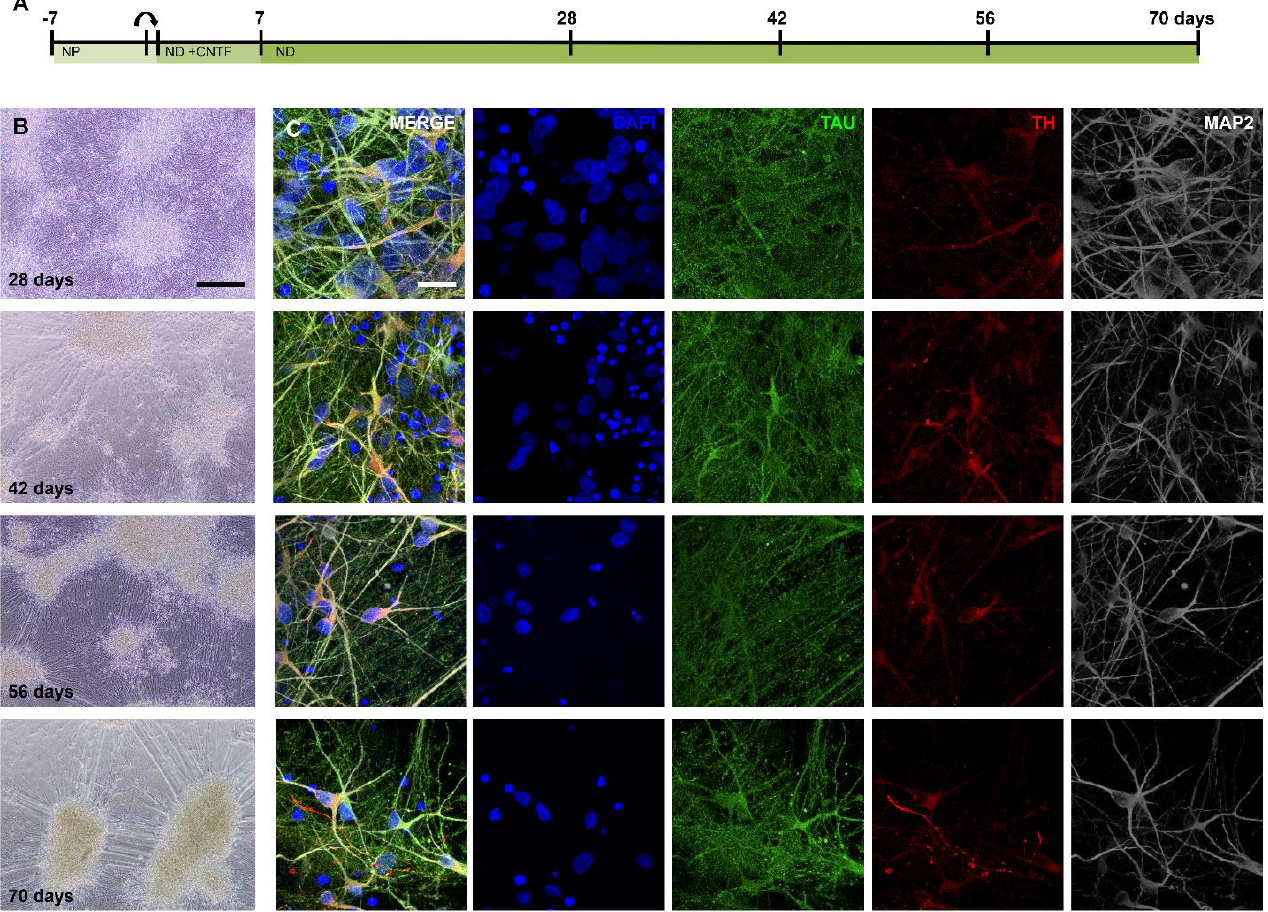
Figure 2. Differentiation of NPC to neuron-astrocyte culture including dopaminergic neurons. ( A ) Timeline of the culture protocol and time points of sampling. Arrow indicates replating to a new culture plate. ( B ) Light images of the neuronal culture differentiating over time. ( C ) Maximum projections (5 µ m) of the same time points as in ( B ) showing neurons (TAU, MAP2) and TH + neurons. Scale bars: ( B ) —200 μm, ( C ) —20 μm.